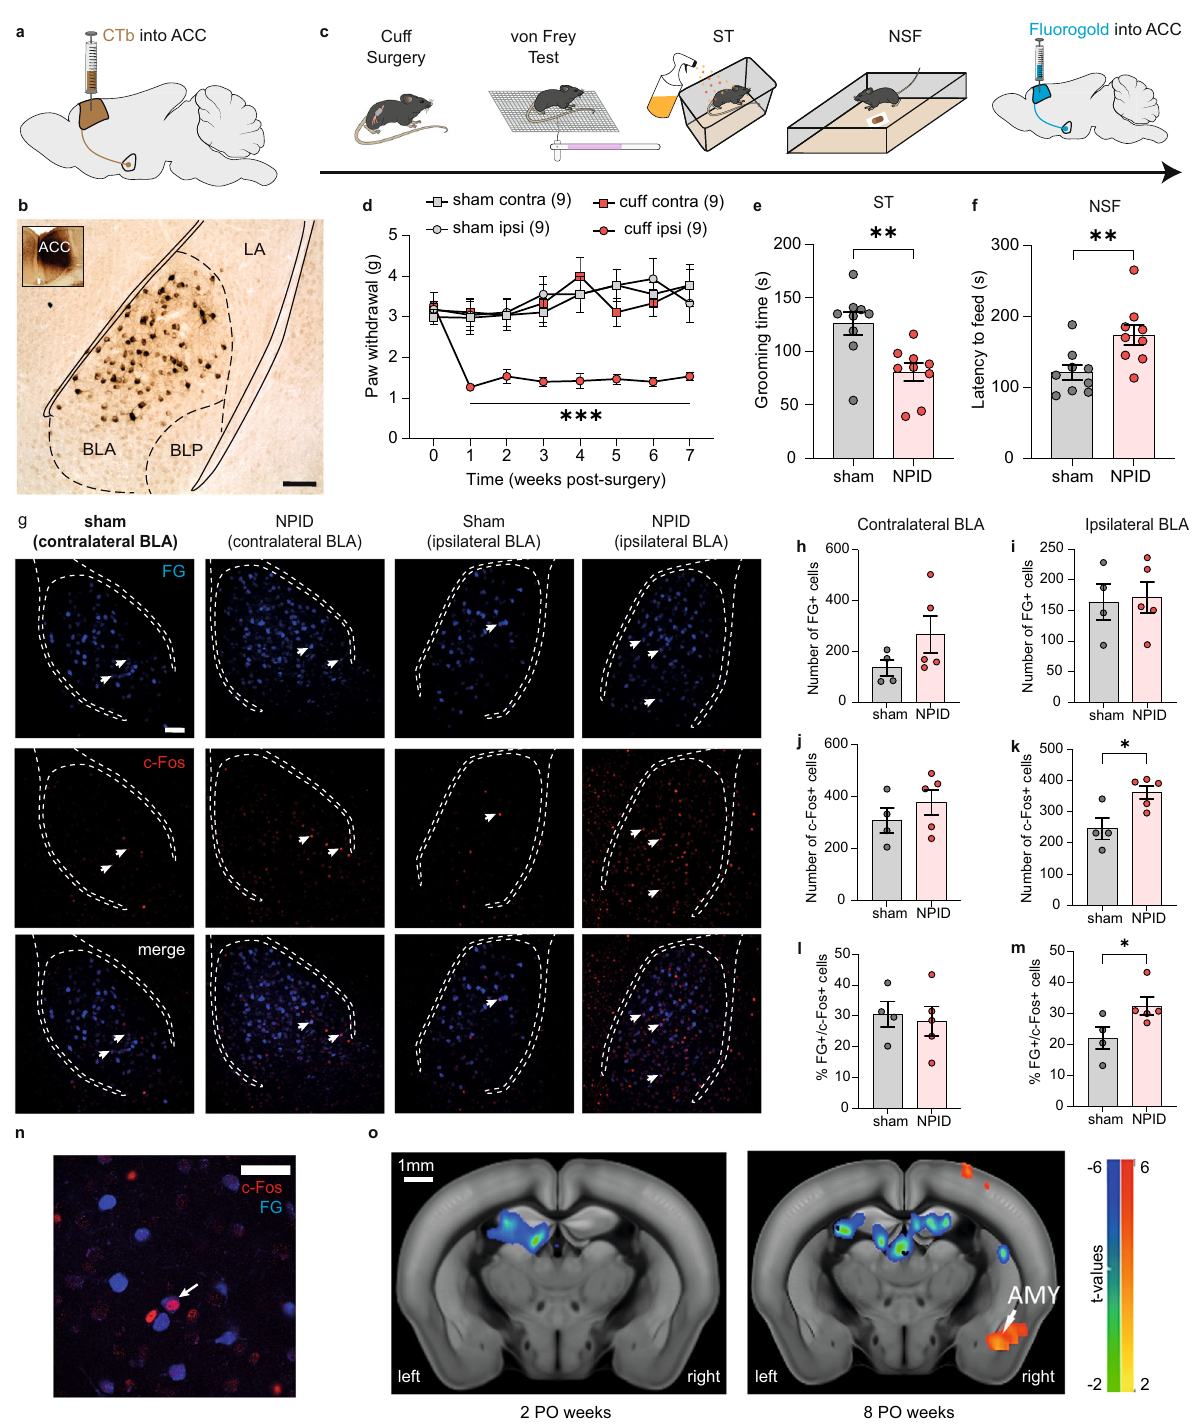
(Fig. 2k, l) in both the ST and FST 11,24 . Inhibiting the BLA – ACC pathway had no impact in the LD test, suggesting that other pathways may control anxiety-like consequences of chronic pain. In contrast, BLA – ACC inhibition completely reversed pain-induced decreased grooming in the ST (Fig. 2k), and signi fi cantly decreased immobility in the FST (Fig. 2l), revealing potent antidepressant-like effects. No effect of optogenetic inhibition was observed in sham animals, indicating that these antidepressant-like effects selectively manifest in the con- text of chronic pain. As a more general measure of emotionality 34 , we also calculated z-scores for each animal across all three tests (LD, ST, FST).ResultsindicatedthatNPIDmiceshowedglobalemotionalde fi cit